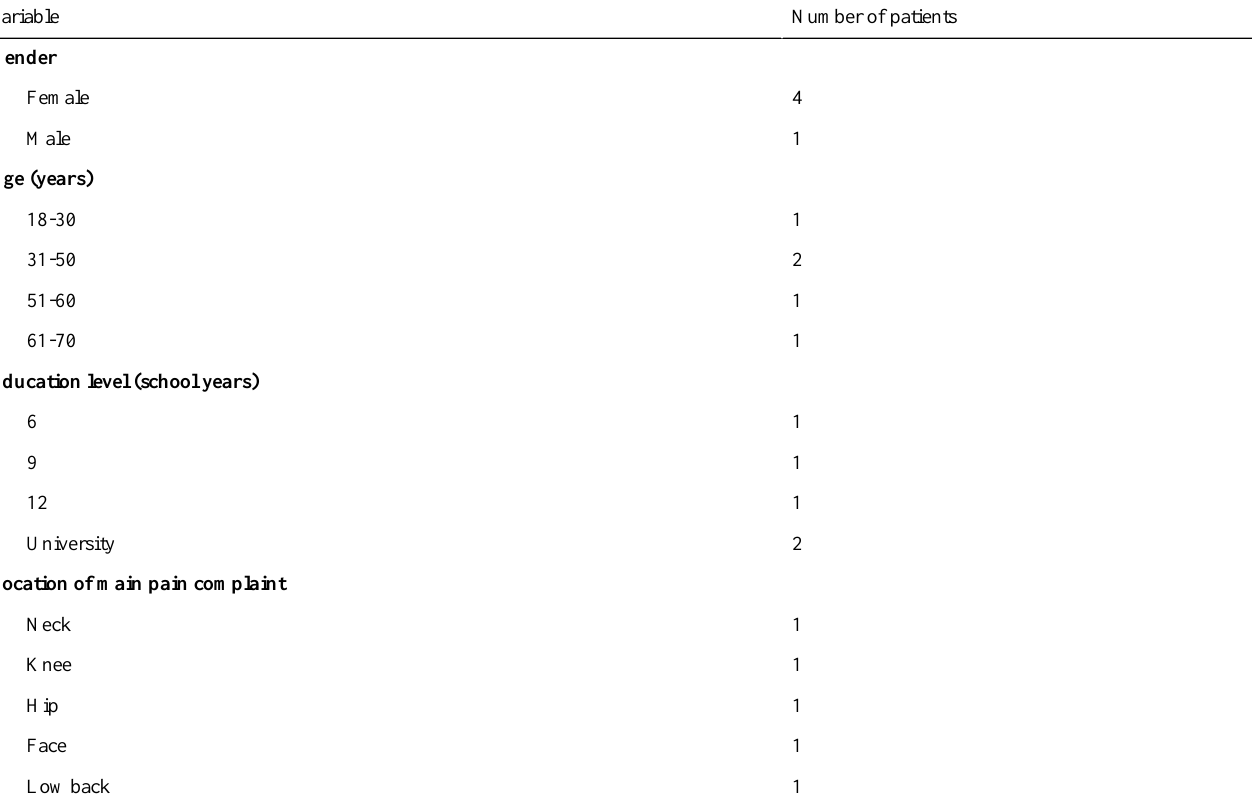
Table 1. Characteristics of patients involved in the development phase (phase 1) of the mobile app (n=5).